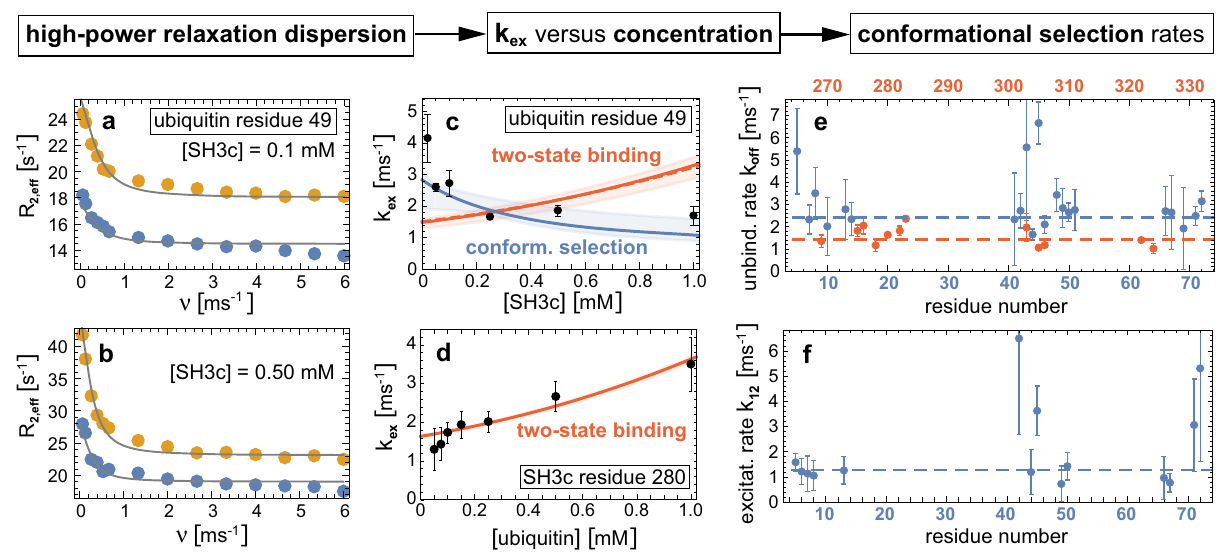
Fig. 2 From relaxation dispersion NMR data to binding mechanisms. a , b Effective transverse relaxation rate R 2,eff versus nutation frequency ν of the applied transverse fi eld measured by 15 N relaxation dispersion for the amide of the ubiquitin residue 49 in the presence of 0.1 mM and 0.5 mM of SH3c. The blue and yellow data points result from measurements at the two 15 N resonance frequencies 60.795 MHz and 96.313 MHz. The gray lines represent fi ts in the fast-exchange regime to determine the exchange rate k “ Methods ” ). c The obtained exchange rates k ex ( ex of the ubiquitin residue 49 (black data points) decrease with increasing SH3c concentration, which indicates conformational selection. The blue and red lines with shaded error regions result from fi ts of the k ex equations of the two-state and conformational-selection binding mechanism (Fig. 1, Supplementary Methods). d For the amide of the SH3c residue 280, the exchange rate k ex increases with the ubiquitin concentration and can be well fi tted with the k ex equation of two-state binding. e Unbinding rates k off obtained from fi ts with the conformational-selection model for ubiquitin residues (blue data points) and from fi ts with the two-state binding model for SH3c residues (red data points, Supplementary Figs. 3 and 4). f Conformational excitation rate k 12 from conformational-selection fi ts of ubiquitin residues (Supplementary Fig. 3). Global and residue-speci fi c uncertainties in the R 2,eff values were estimated as described in Methods. The larger one of these two uncertainty estimates for each data is reported (smaller than the plot markers). The error bars in ( c – f ) represent standard errors of data fi ts ( “ Methods ” and Supplementary Methods). Source data are provided as a Source Data fi